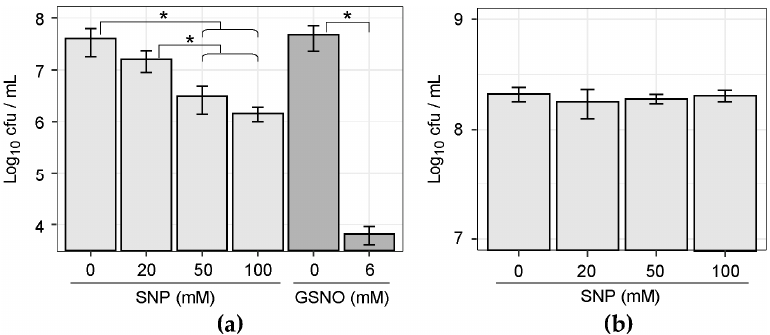
Figure 6. Effect of NO donor on the cell viability of bacterial strains. ( a ) Viability of F. nucleatum subsp. polymorphum growing in the presence or absence of NO donor SNP or S-nitrosoglutathione (GSNO). ( b ) Viability of C. concisus growing in the presence or absence of SNP. Values are expressed as the